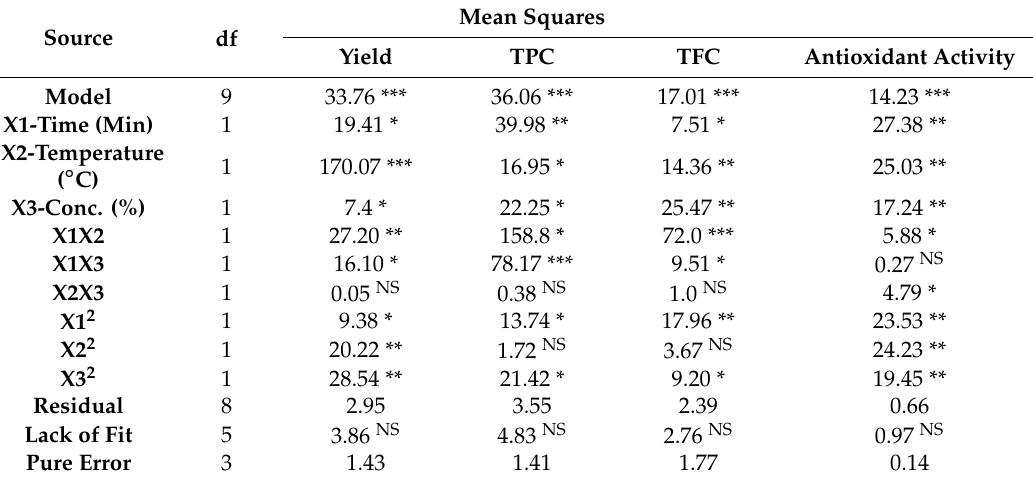
Table 4. Statistical result of response surface